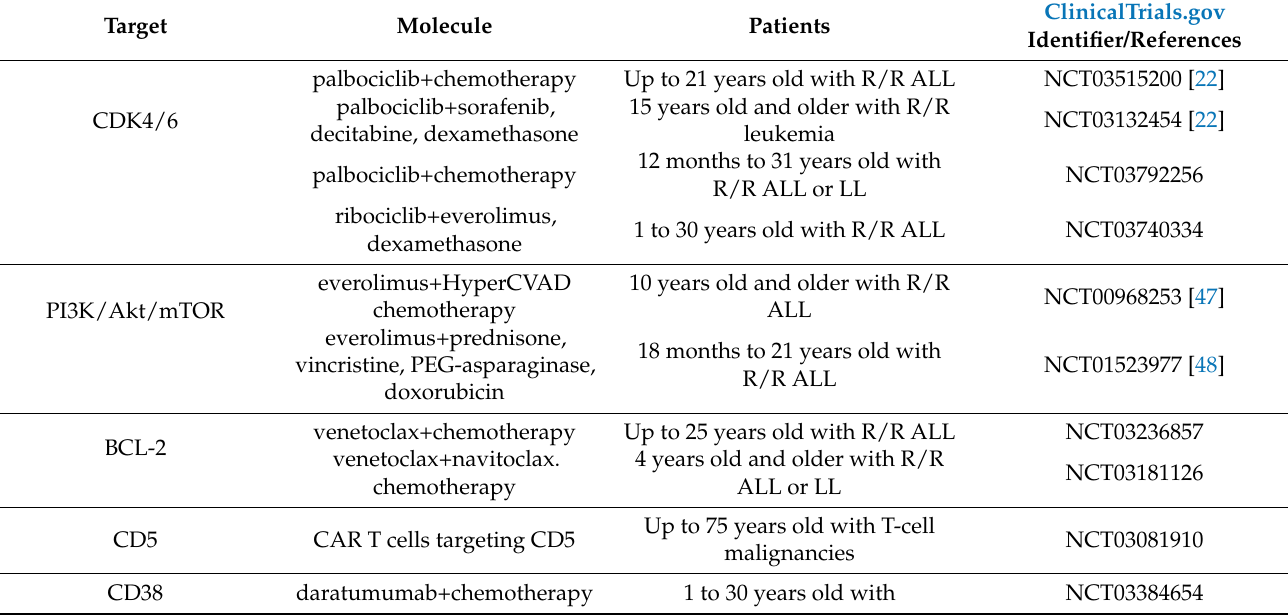
Table 1. Selected clinical trials including children with